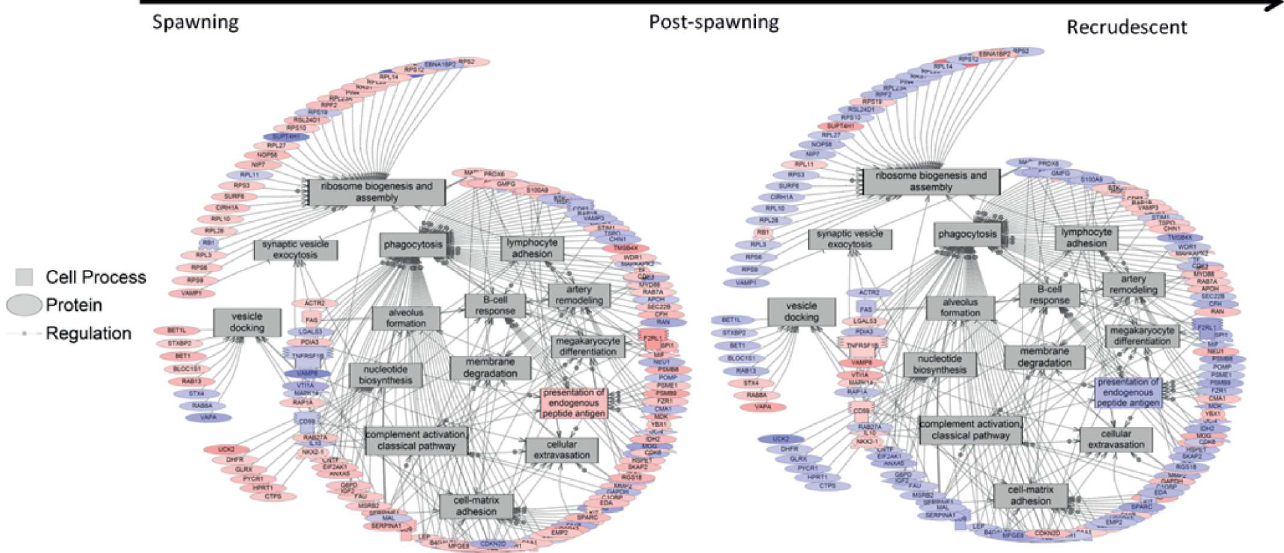
Fig 8. Processes activatedin the transition from spawning to post-spawning. These processes are then suppressedas the testis enters recrudescence and begins a new maturation cycle. Blue colors genesrepresent a down-regulatedgene and red colored figures represent an up- regulated